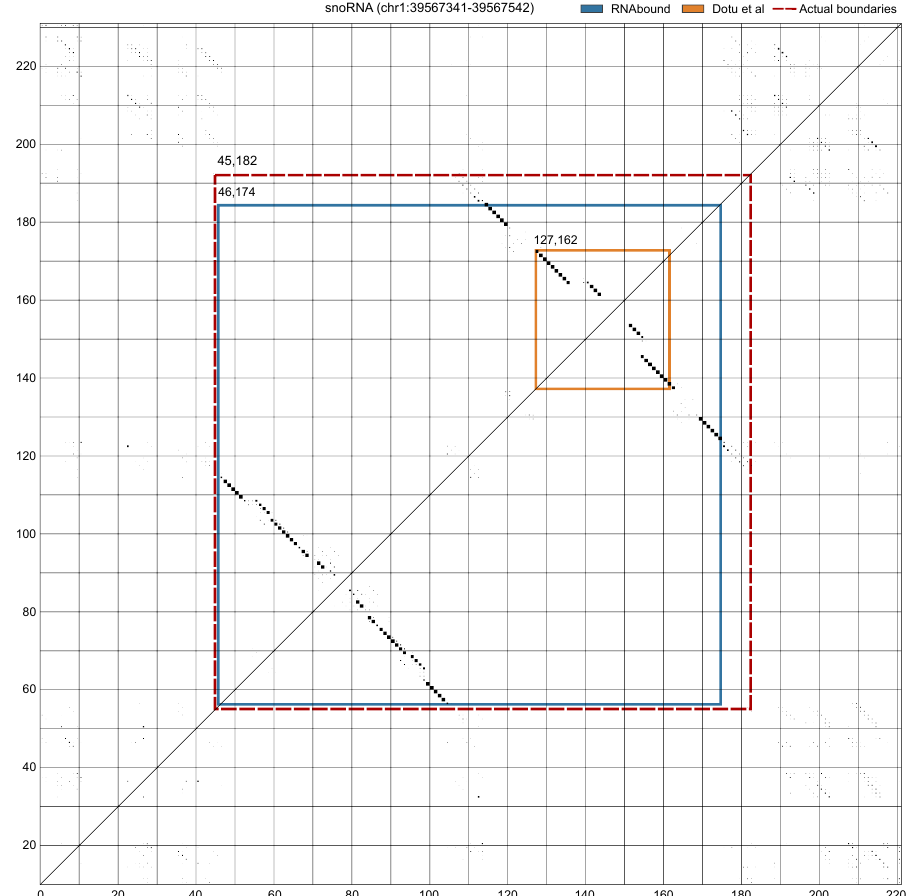
Figure 4. Dot plot shows the PETfold base pairing probabilities computed from the multiple sequence alignment of a window 200 nucleotides (nts) centered on an H/ACA-box snoRNA (RF00431). Each dot corresponds to base pairing of two bases in the respective positions (along the x- and y-axis) and the size of the dot corresponds to the probability. The bigger the size the higher the pairing probability. Due to the gaps in the multiple sequence alignment, the size of dot plot exceeds the window size 200 nts. The actual and predicted boundaries of the snoRNA are highlighted in the plot: ( a ) actual boundaries (45, 182—red dashed lines); ( b ) RNAbound predicted boundaries (46, 174—blue lines); and ( c ) Dotu et al. prediction (127, 162 orange lines). The boundaries predicted by RNAbound are closer to the actual boundaries ( − 1 bases short on the left and –8 bases short on the right), whereas the boundaries predicted by the Dotu et al. approach covered only the short substructure and are of − 82 and − 20 bases short on the left and right, respectively, as compared to the actual